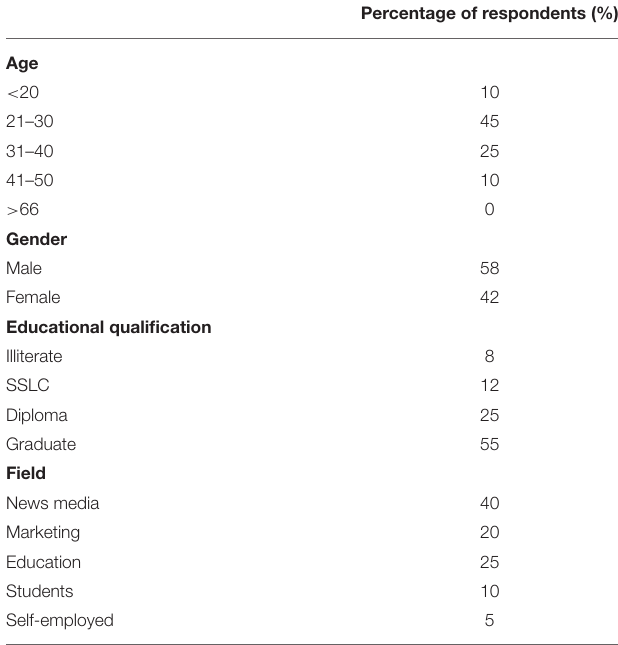
TABLE 1 | Demographic details of the